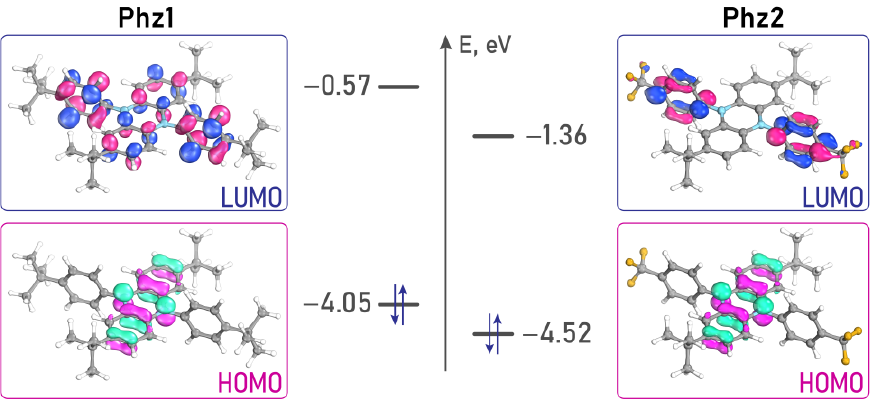
Figure 7. The HOMO/LUMO localization and the corresponding orbital energies for Phz1 and Phz2 (PBEh-3c).